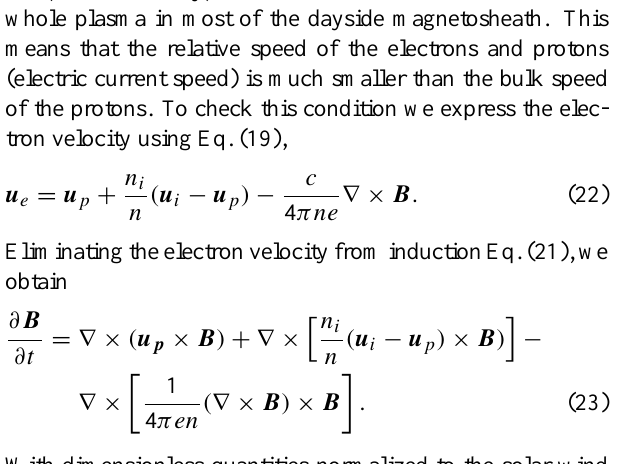
solar wind magnetic field into the ionosphere because of the magnetic diffusion